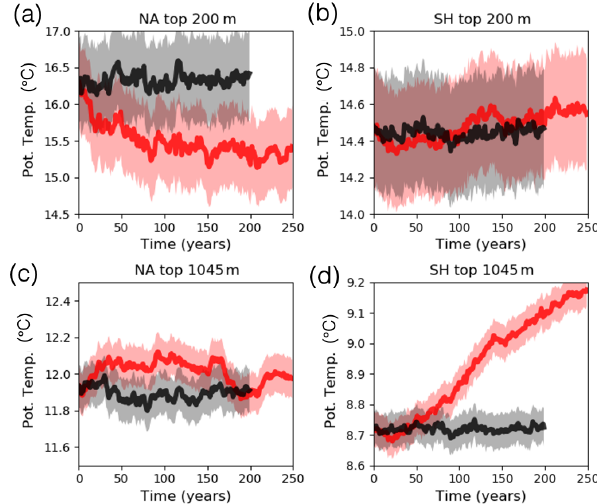
Figure 2. North Atlantic (NA) and Southern Hemisphere (SH) depth-averaged means of seawater potential temperature for LIG_hosing (red) and LIG (black). (a, b) Averages over the top 200m of the water column, (c, d) averages over the top 1045m of the water column. Thick lines are annual means, shaded areas rep- resent the standard